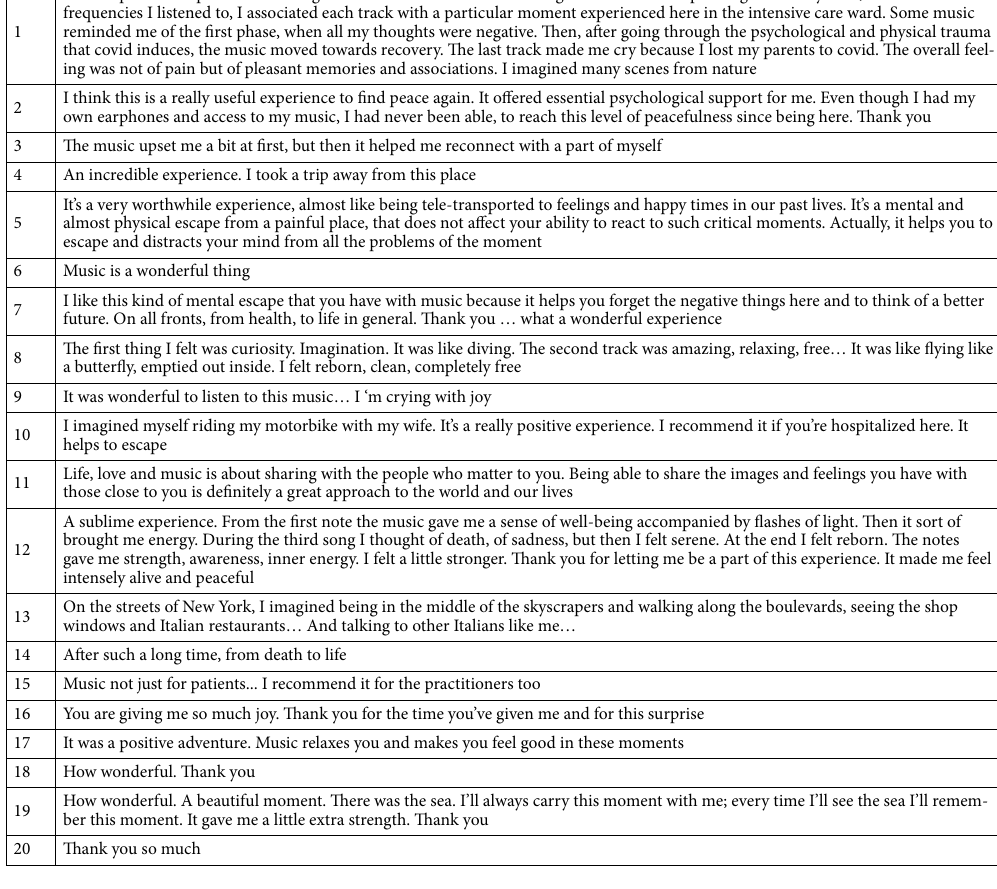
Table 2. Comments provided from patients by the end of